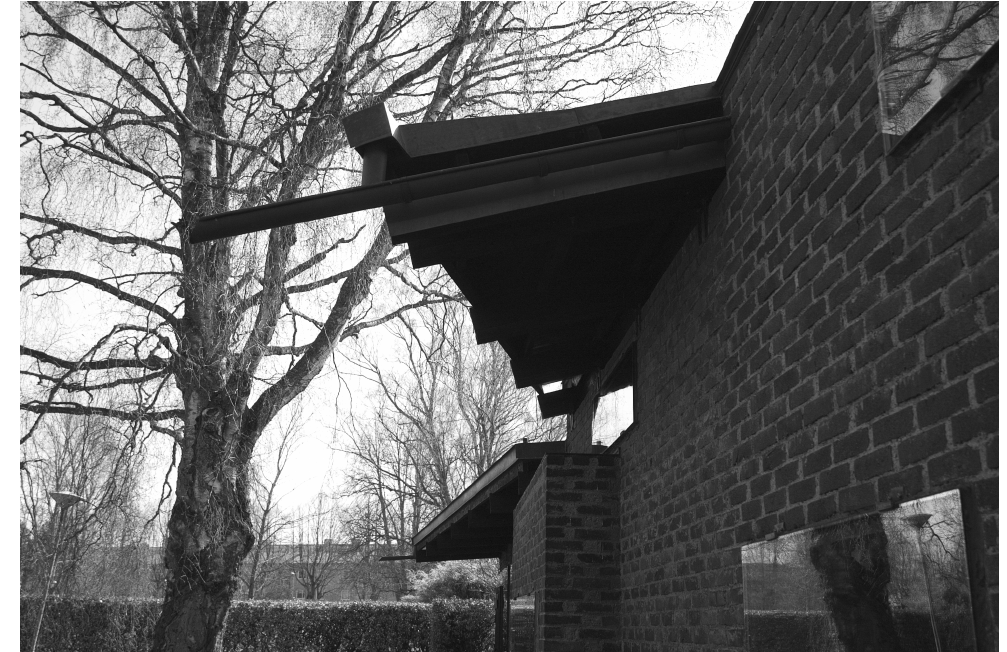
Figure 6: Gutter detail on east facade of Parish